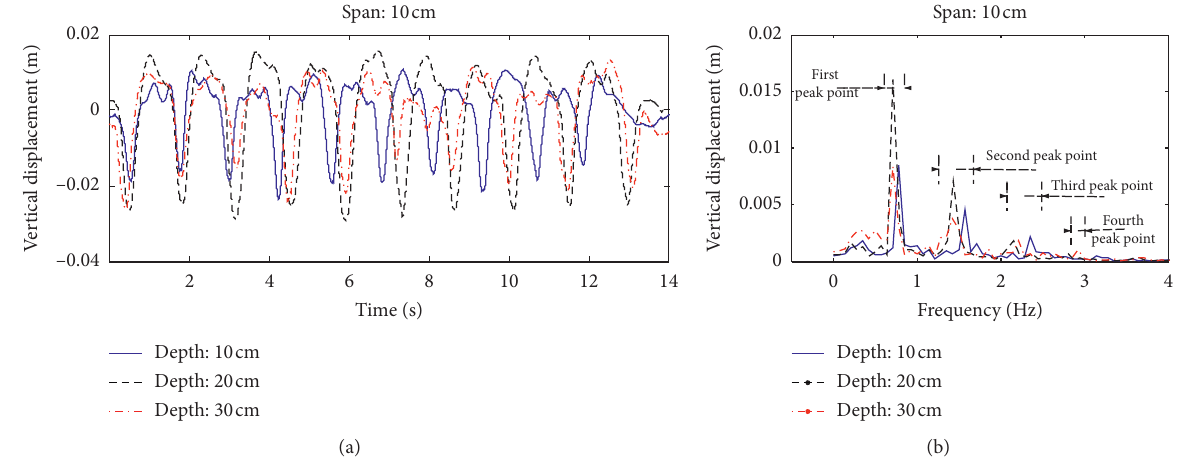
Figure 10: Time-frequency correspondence diagram of effective roughness. (a) Time domain diagram. (b) Frequency domain